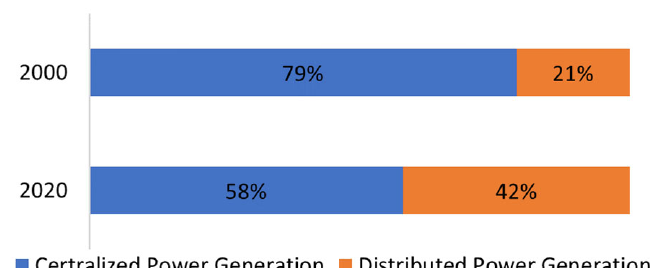
Figure 1. Share of DEG in the global power generation.